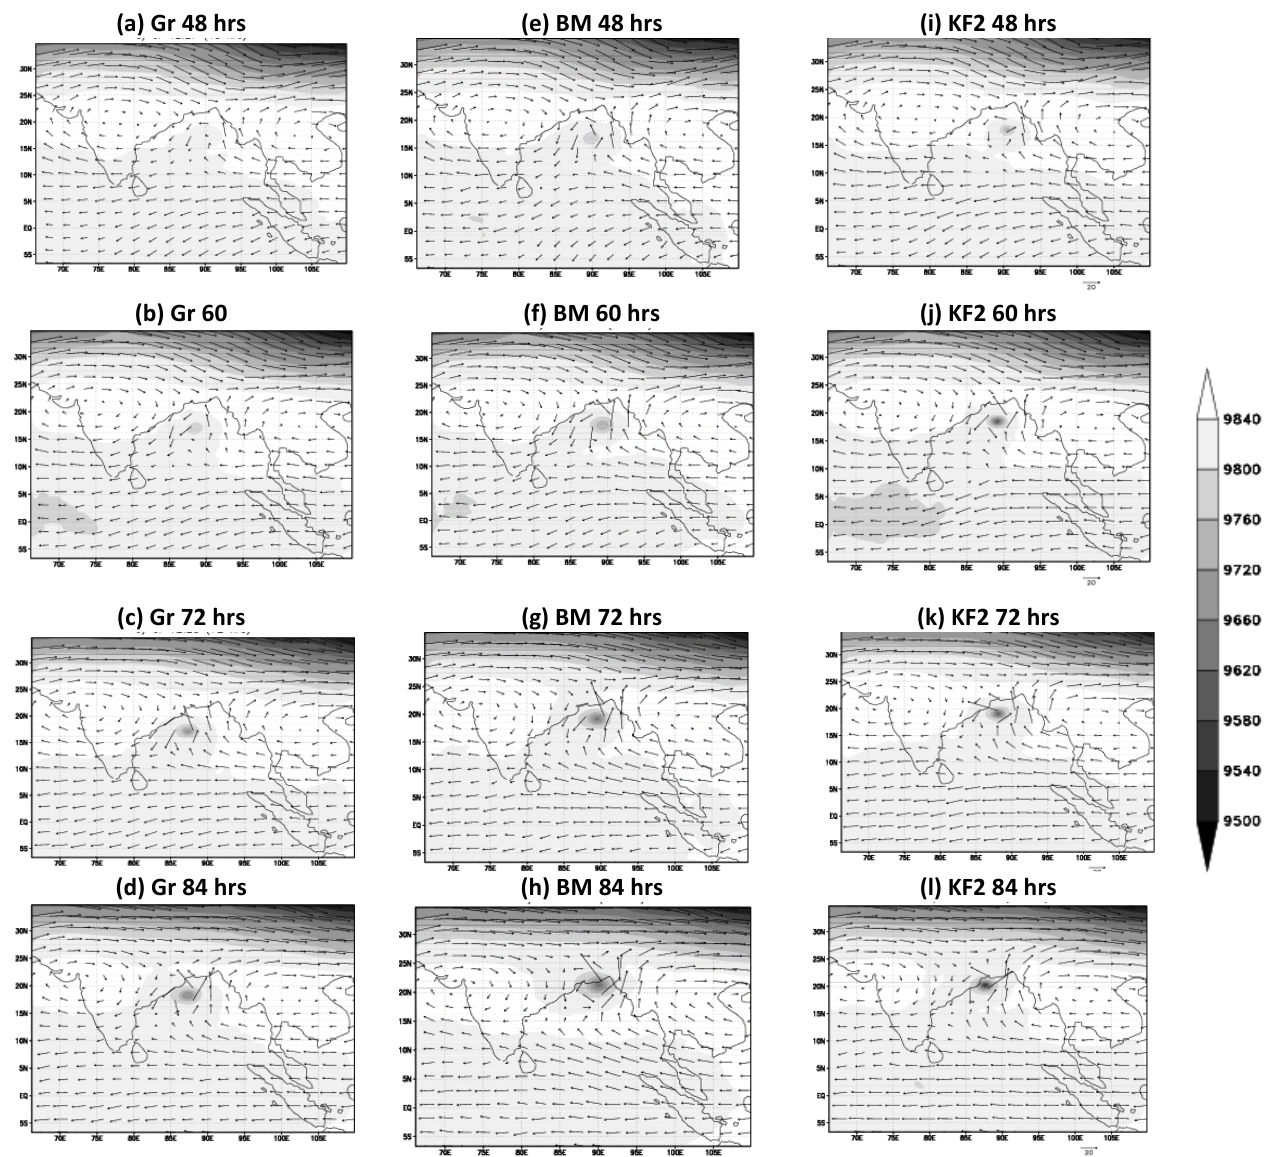
Fig. 3. Layer-averaged (400hPa–200hPa) geopotential height in meters (shaded) and wind direction and magnitude in ms − 1 (vectors), simulated by CPS of Gr (a) – (d) , BM (e) – (h) and KF2 (i) – (l) each at 48, 60, 72 and 84h of